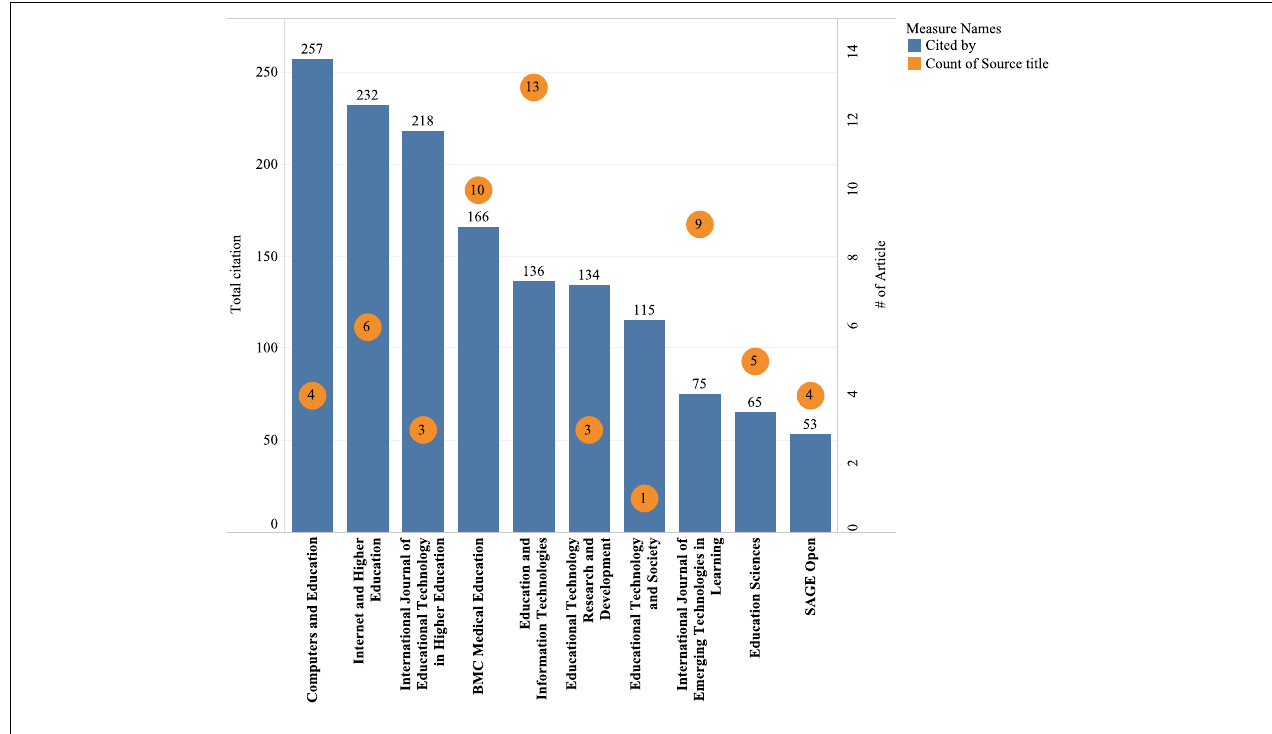
FIGURE 3 | Compare the article’s number and total citation based on